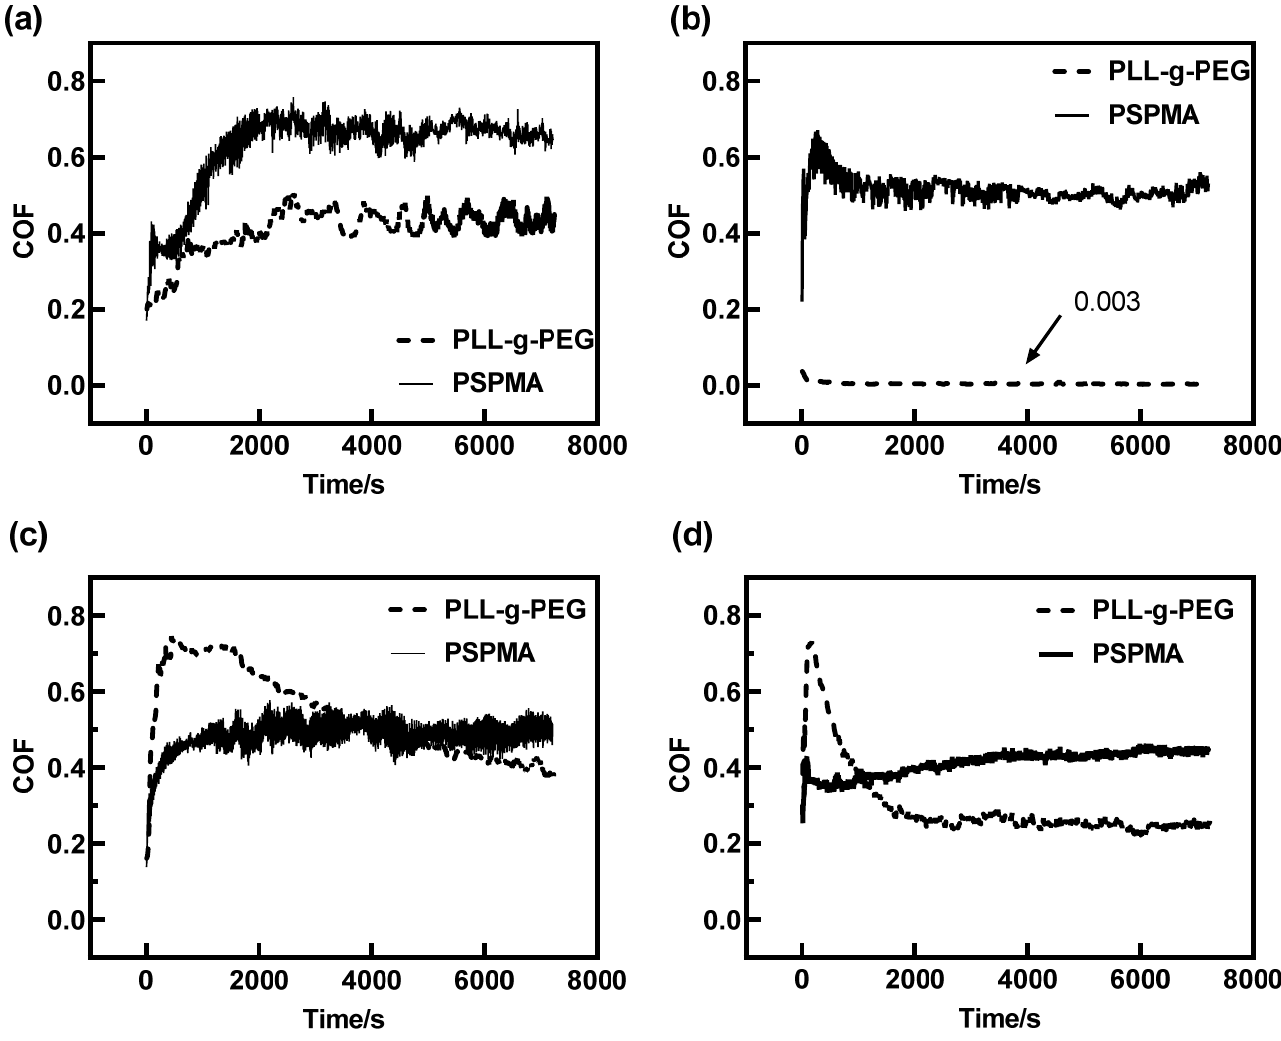
Figure 4. Comparison of friction curves of two polymer brushes vs. time at different loads and velocities: ( a ) Load = 0.5 N, U e = 10 mm/s; ( b ) Load = 0.5 N, U e = 300 mm/s; ( c ) Load = 3.5 N, U e = 10 mm/s; and ( d ) Load = 3.5 N, U e = 300 mm/s.